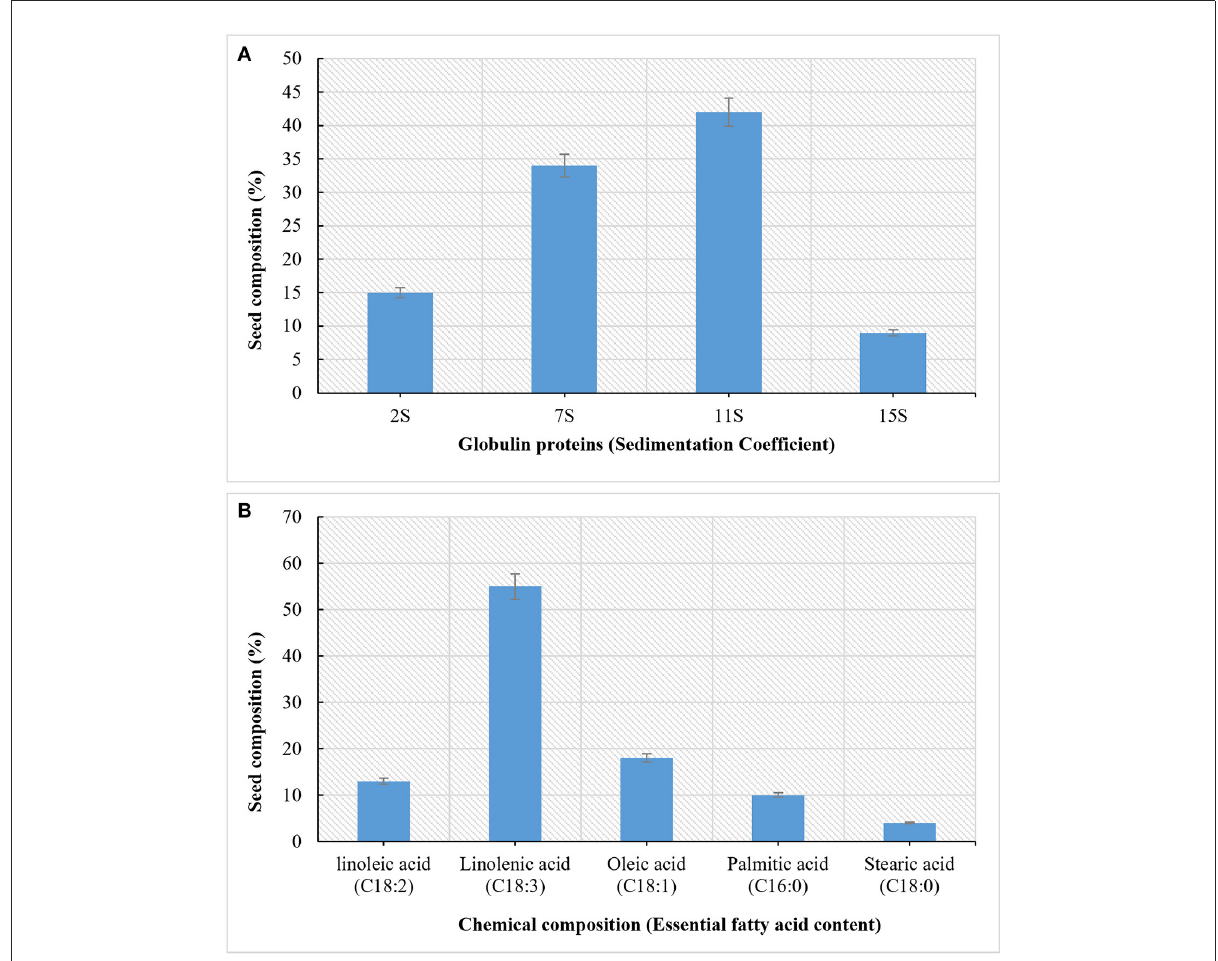
FIGURE1 Composition of protein (A) and oil (fatty acids) (B) in soybean seeds. Data sourced from Yao et al. (2020) and Guan et al. (2021).